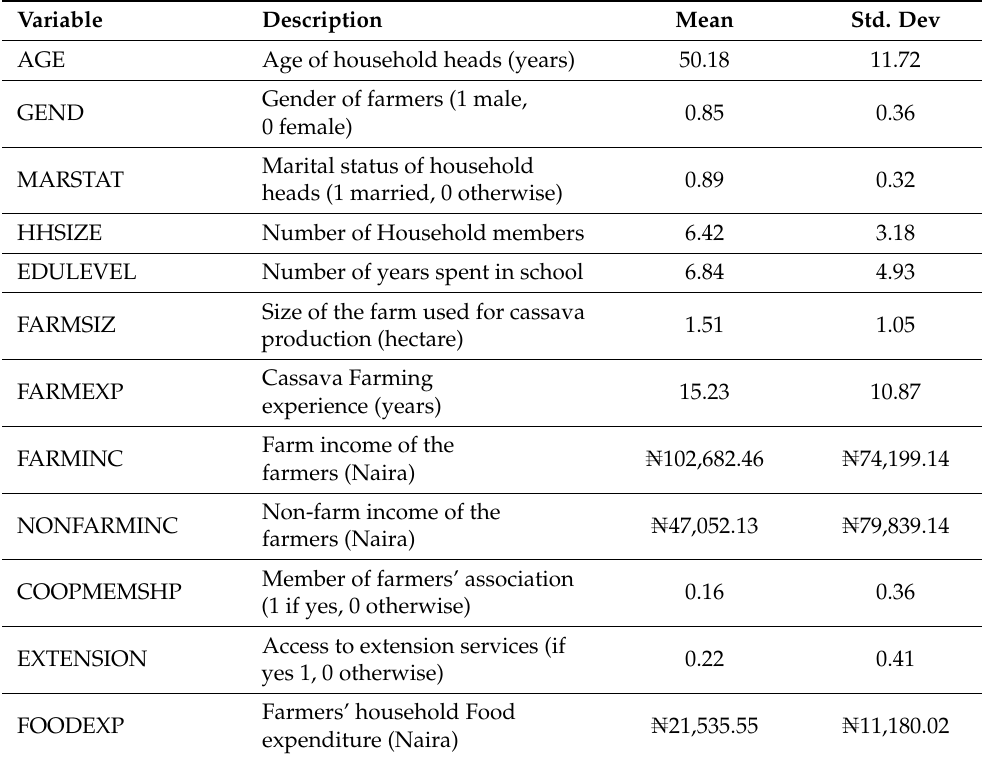
Table 3. Distribution of socioeconomic characteristics of farming